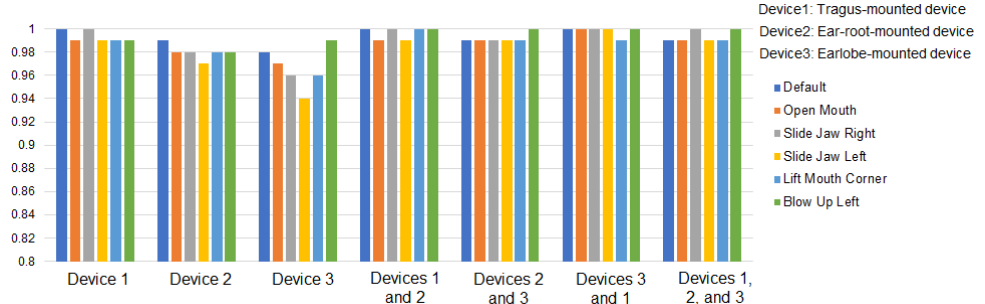
Figure 12. The results of each gesture in Evaluation 2 using six gestures. The average F-value for each device pattern.